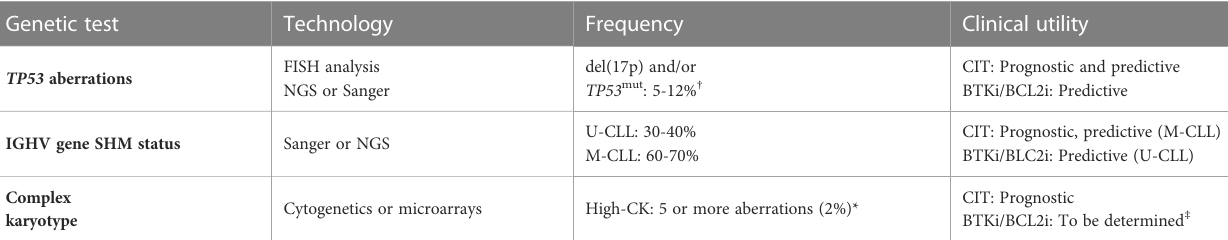
TABLE 1 Genetic tests in